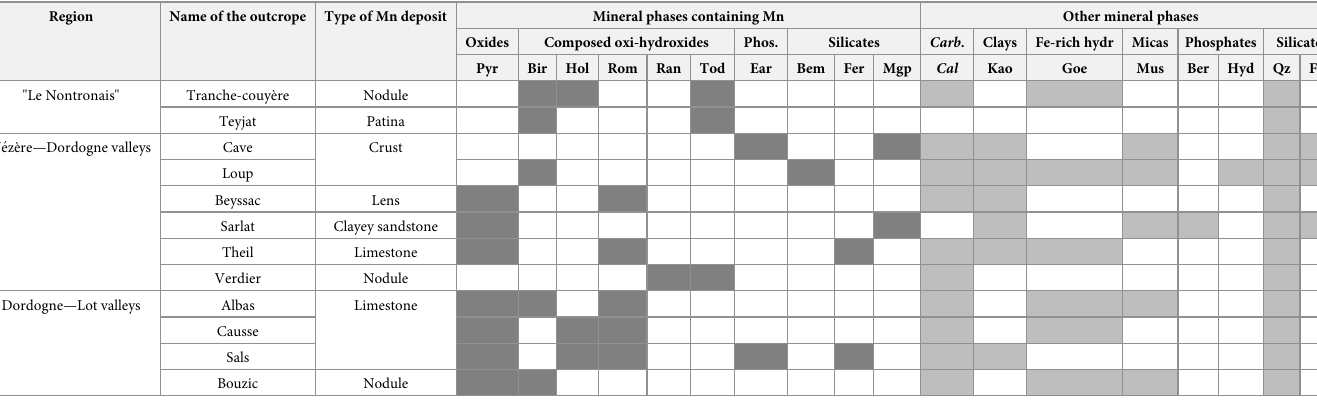
Fig 7. Mn/Si ratio of the manganese-rich rocks. Mn/Si ratio of modified and unmodified manganese-rich rocks from Le Moustier by size and weight.